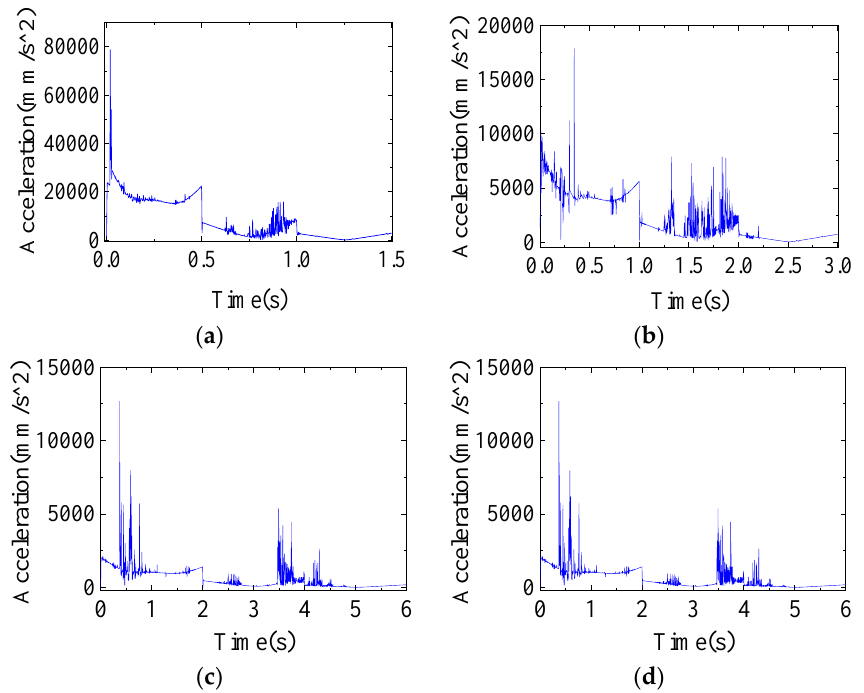
Figure 9. Curve of end acceleration change at different rotational speeds: ( a ) Velocity_1; ( b ) Velocity_2; ( c ) Velocity_3; ( d ) Velocity_4.